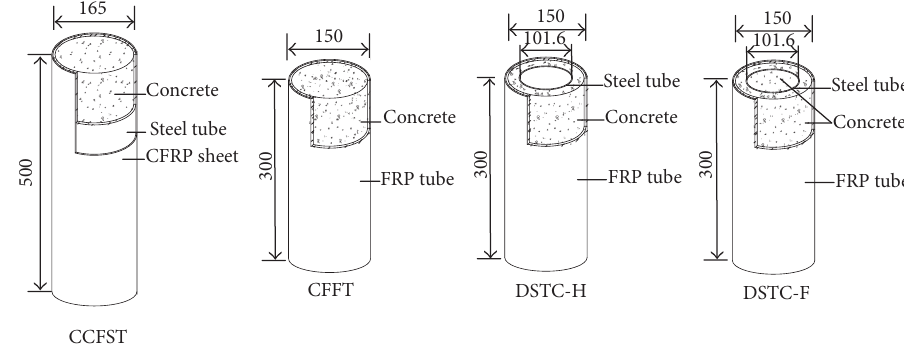
Figure 9: The schematics of four columns. Table 4: Comparisons of CCFST, CFFT, DSTC-H, and